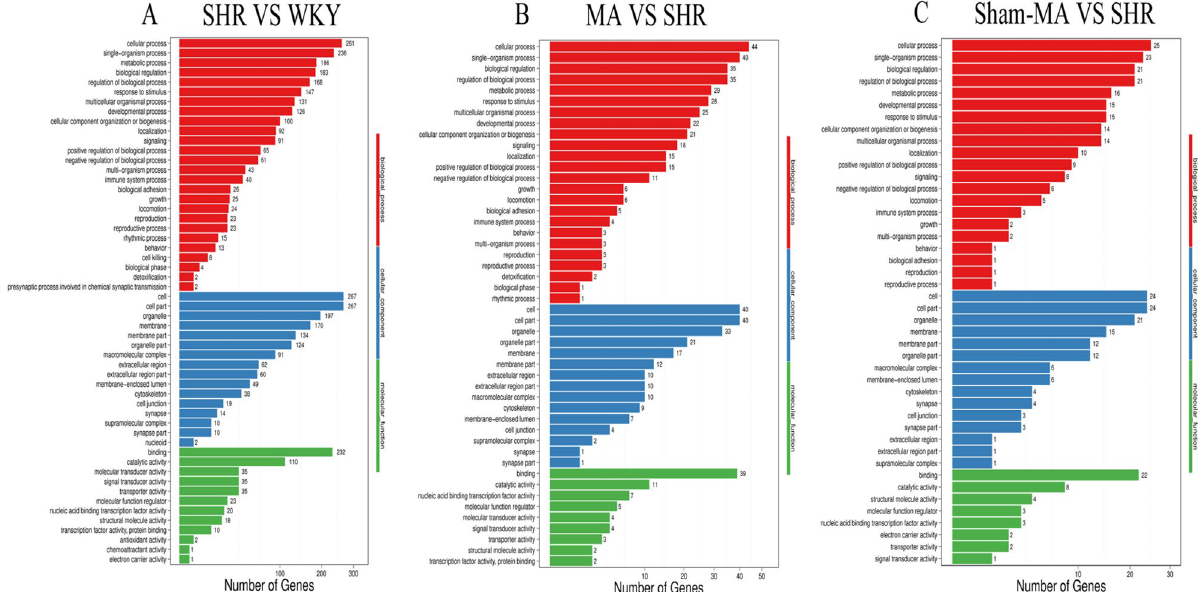
Figure 5. The DEGs number of the most enriched Gene Ontology (GO) terms between WKY, SHR, MA and Sham-MA. ( A ) SHR versus WKY; ( B ) MA versus SHR; ( C ) Sham-MA versus SHR. GO analyses were performed using enrichment analysis with the phyper function in R version 3.6.0 (https:// cran.r- proje ct. org/ bin/ windo ws/ base/ old/3.